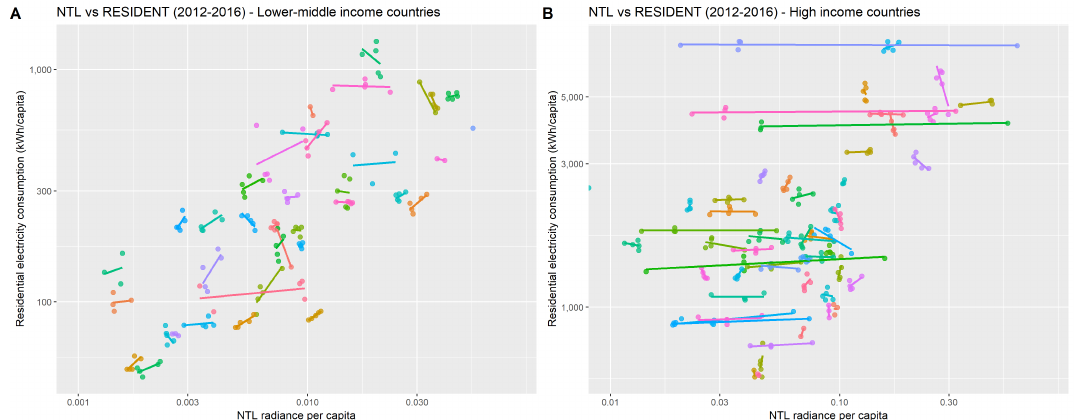
Figure A1. NTL vs. RESIDENT for ( A ) lower-middle income and ( B ) high-income countries (annual values between 2012–2016).